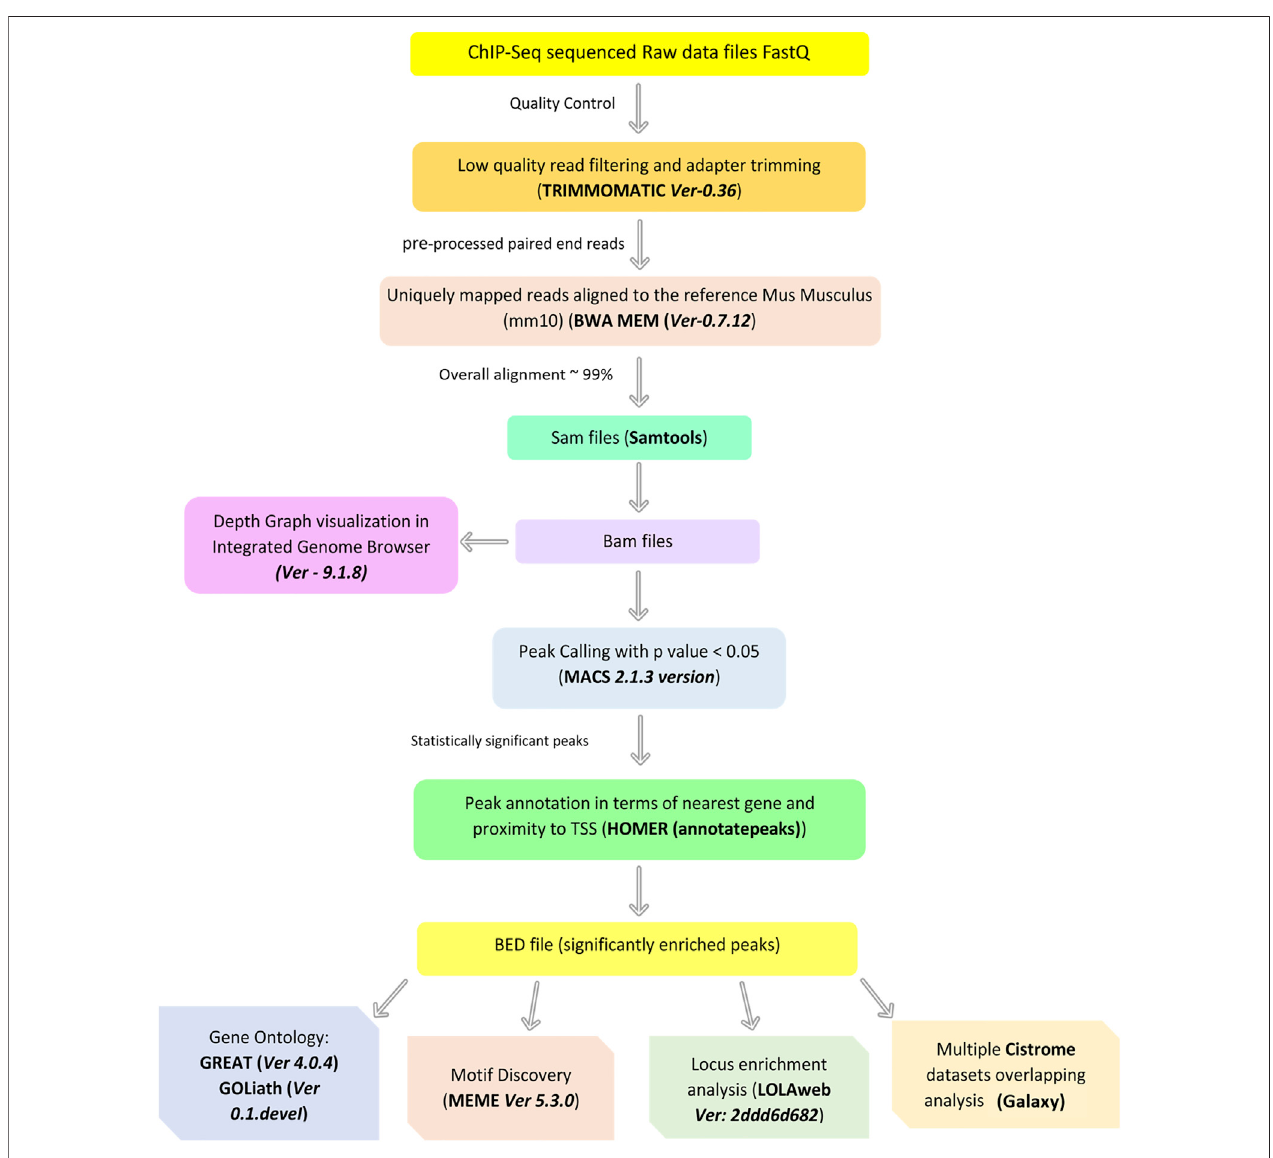
FIGURE 3 | Brief summary of the ChIP-Seq data processing and downstream analysis undertaken in this study.